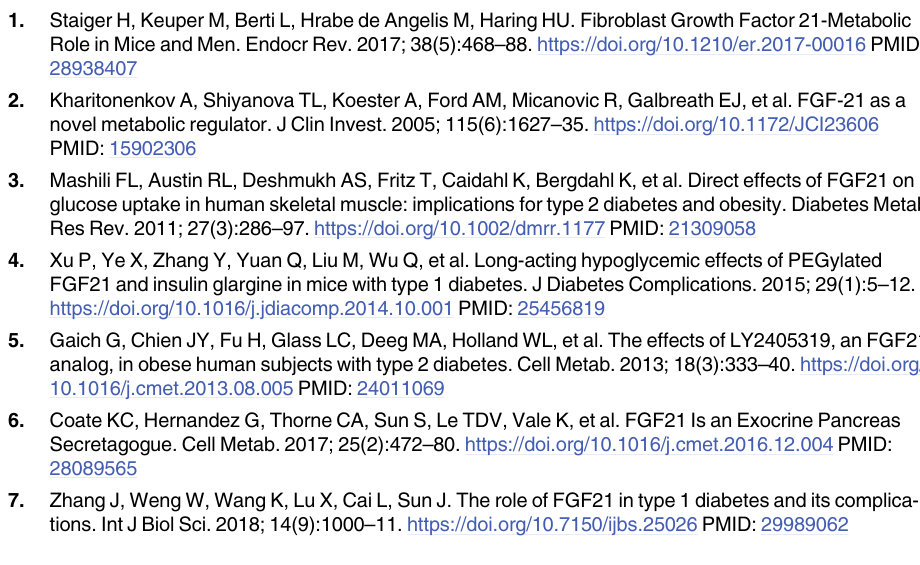
S1 Table. Relationship between BMI and estimated serum FGF21 levels in T1DM patients. The estimated serum FGF21 levels were calculated using stepwise multiple linear regression analysis (Table 4). ⊿ FGF21 was calculated by subtracting the estimated serum FGF21 level with a BMI of 20 kg/m 2 . Regression equation: log FGF21 (pg/mL) = 0.500 + 0.032BMI (kg/m 2 )